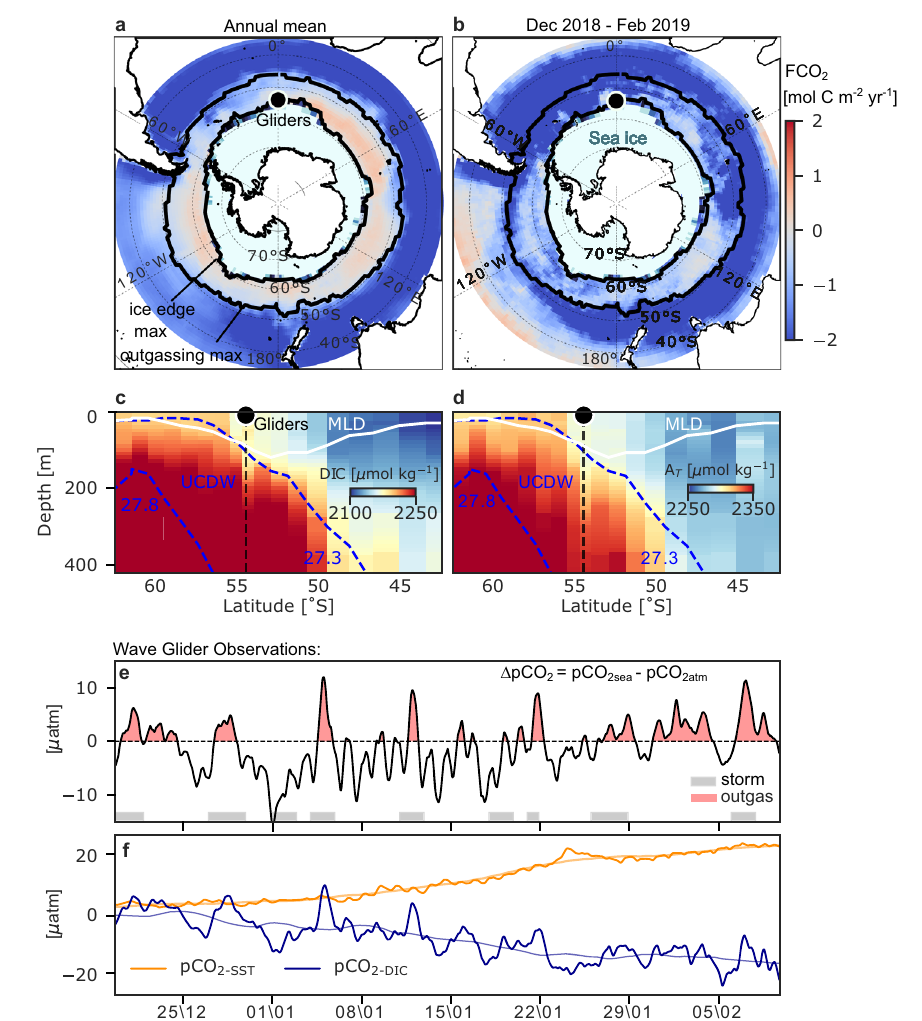
Fig. 1 Observed temporal variability of Δ pCO 2 in the outgassing domain of the Southern Ocean. a The annual mean (2005 – 2019) net air-sea CO 2 fl ux (F CO2 ) [mol C m − 2 yr − 1 ] from CSIR-ML6 1,41 . Overlaid is the climatological sea-ice concentration maximum from NCEP-DOE AMIP-II Reanalysis 2 81 . The black dot marks the location of the robotic platforms (labelled Gliders comprising a Wave Glider and Slocum glider). The subpolar outgassing region considered here is between the climatological sea-ice-edge maximum and the extent of the zonal band of maximum outgassing for 2005 – 2019 determined by the 0 contour of the CO 2 fl ux in winter (June – August), shown by black contours. b is as in a except F CO2 is averaged over only the Gliders deployment period (Dec – Feb 2019). An example meridional section of c Dissolved Inorganic Carbon (DIC) [ µ mol kg − 1 ] and d Total Alkalinity (A T ) [ µ mol kg − 1 ] along the Good Hope Line (transect AX25) during 2016 from GLODAPv2.2020 82,83 . The dashed blue contours (27.3 and 27.8 kg m -3 isopycnals) are the upper and lower bounds of the Upper Circumpolar Deep Water (UCDW). The white contour is the mixed-layer depth (MLD). e Wave Glider observed Δ pCO 2 , which is the difference between the partial pressure of CO 2 in the surface ocean (pCO 2sea ) and in the atmosphere (pCO 2atm ) in µ atm. Grey bars highlight the central part of a storm passage de fi ned using the 25 th sea level pressure and 75 th wind speed percentiles (Supplementary Fig. 2). f Decomposition of pCO 2sea into its thermal (pCO 2-SST ) and non-thermal (pCO 2-DIC ) drivers. The thick lines represent the cumulative contribution of each process to the observed changes in Δ pCO 2 relative to the start of deployment (time = 0). The thin lines show the 10-day rolling mean. Time is given as dd\mm of 2018 and